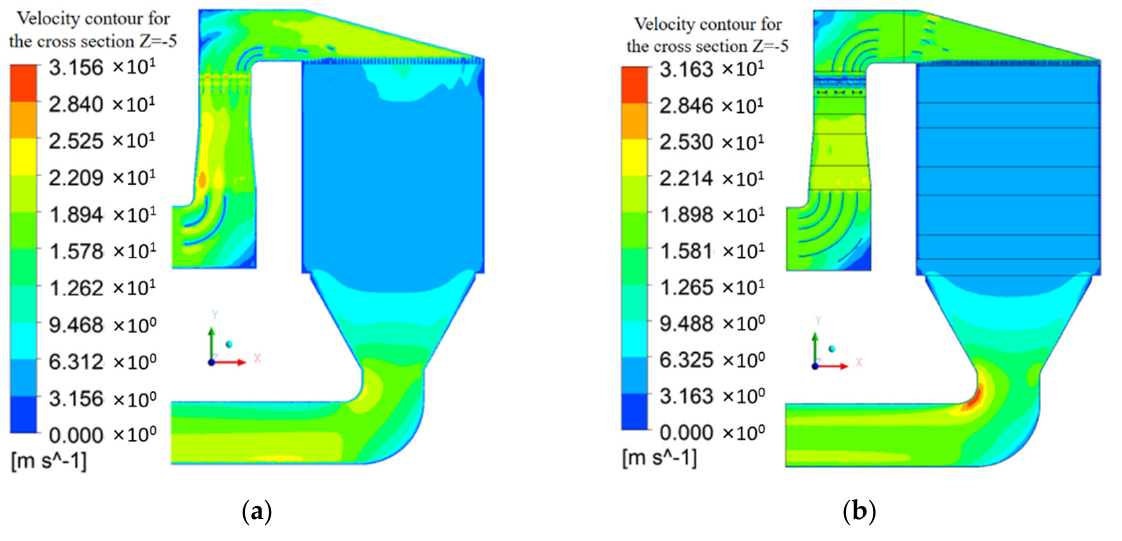
Figure 8. Contours of the flow distribution of Scheme 1 and Scheme 4.4 for the cross − section X = 3: ( a ) Scheme 1; ( b ) Scheme 4.4.